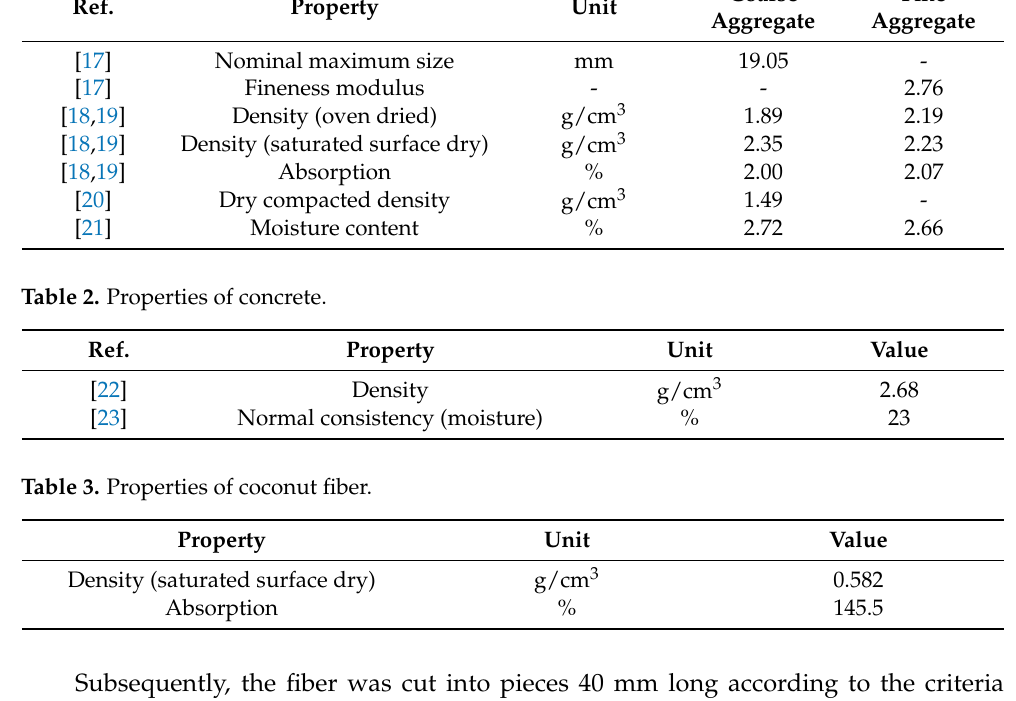
Table 1. Properties of coarse and fine aggregates. Table 2. Properties of concrete.